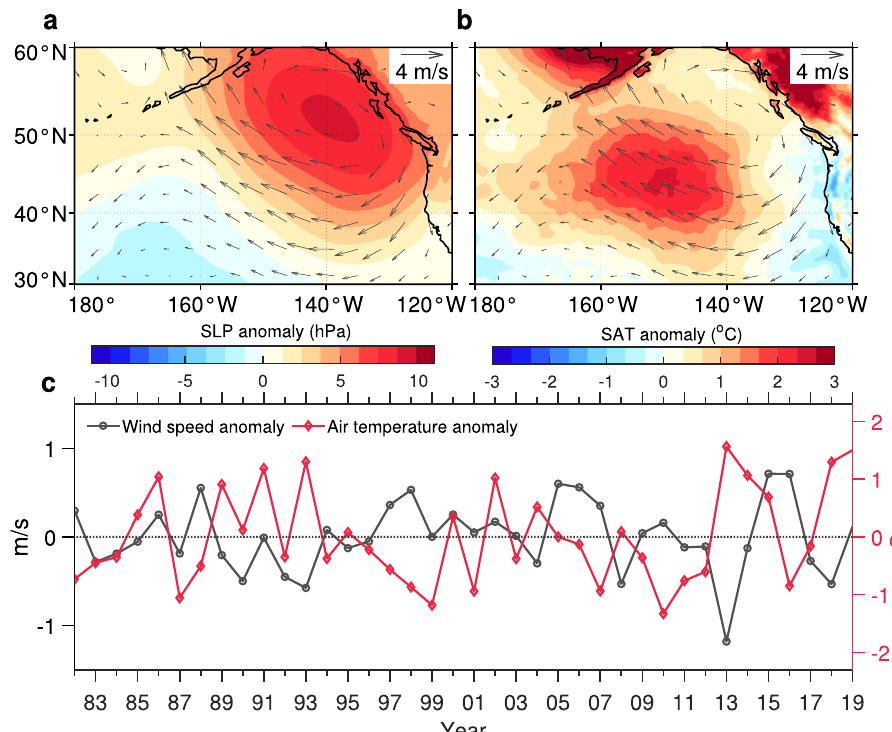
Fig. 2 Anomalous atmosphere fi elds in the NE Paci fi c. Anomalies of ( a ) sea level pressure and ( b ) air temperature overlaid with wind fi elds (arrow) in the NE Paci fi c during the winter (October – January) of 2013/2014. c Time series of wind speed anomalies (black) and air temperature anomalies (red) averaged over 40°N – 50°N, 135°W – 150°W (black outline in Fig. 1) in winter from 1982 to 2019. (Supplementary Fig. 2a). The combined positive SLP anomalies and negative wind speed anomalies suggested that atmospheric forcing was an important driver of the Blob. During the winter with the anomalously warm SSTs, there was also an anomalously southeastward wind over the study area on the west side of the anticyclonic SLP anomalies, which transported a warm air mass from the low-latitude region. Therefore, the time series of the air temperature (Fig. 2b) and speci fi c humidity (Supplementary Fig.